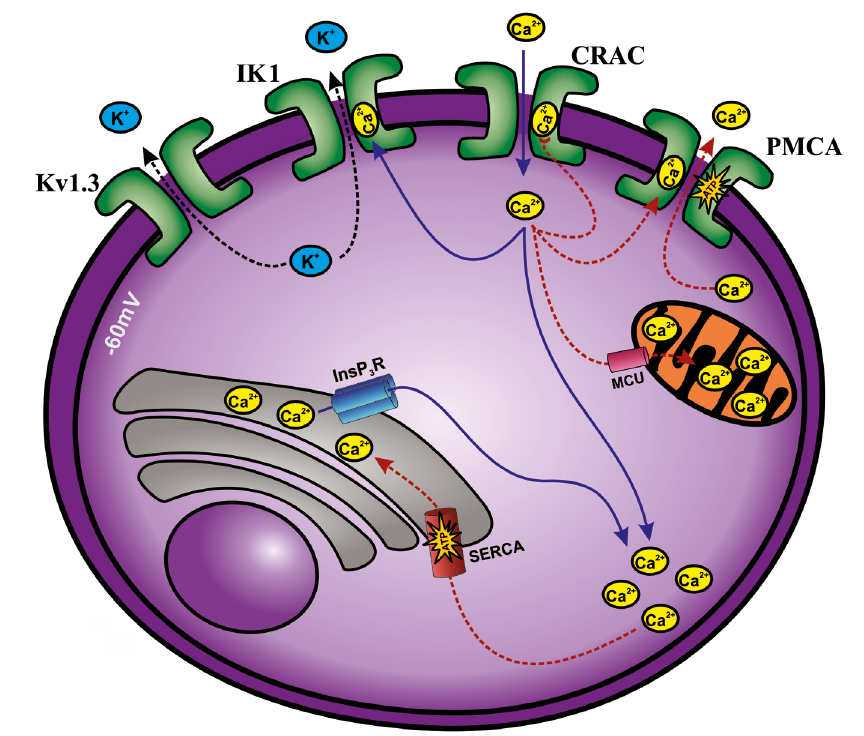
Figure 1. Kv1.3 and Ca +2 signaling in T cells. Depolarization of the T cells (about -60 mV) reduces the driving force for Ca +2 entry through calcium-release- activated calcium (CRAC) channels, which is counteracted by the opening of Kv1.3 channels. On the other hand, IK1 (intermediate conductance calcium-activated potassium channel protein 1) channels open in response to Ca +2 influx and increased intracellular Ca +2 concentration. Ca +2 are diminished by the ATP-dependent Ca +2 pumps - SERCA (sarco/endoplasmic reticulum Ca +2 ATPase) and PMCA (plasma membrane Ca +2 ATPase). PMCA is activated by increases in intracellular Ca +2 signals. Mitochondria can take up and store large amounts of Ca +2 from the cytoplasm using MCU (mitochondrial Ca +2 uniporter) or it can sequester Ca +2 locally. Iinositol-1,4,5-trisphosphate receptor (InsP3R) can also senses Ca +2 waves and enhance intracellular Ca +2 levels. Blue solid lines represent the pathways that enhance intracellular Ca +2 levels. Red dashed lines represent the pathways that reduce intracellular Ca +2 levels. Black dashed line represents K + efflux.